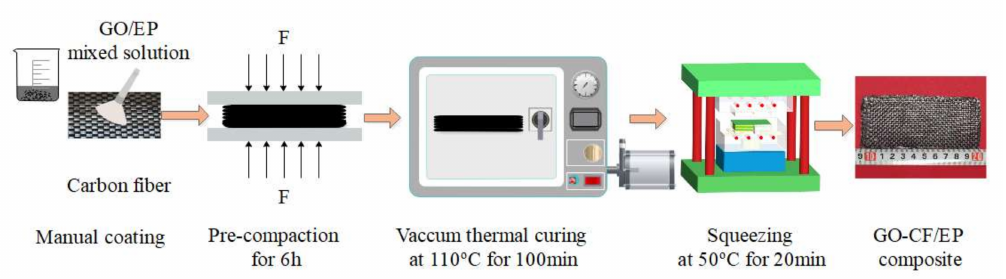
Figure 3. Preparation process of GO-CF/EP